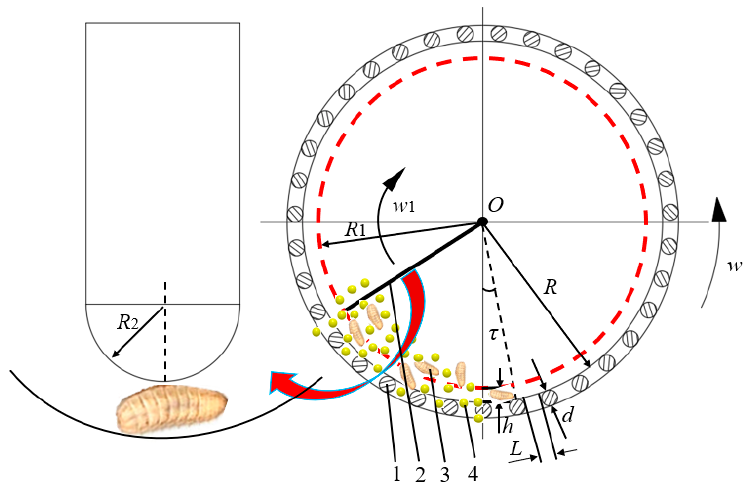
Figure 6. Schematic diagram of the cylinder sieve and nail tooth structure size. 1—tube screen; 2— nail tooth; 3—BSF larvae; 4—BSF sand particle. 2—nail tooth; 3—BSF larvae; 4—BSF sand